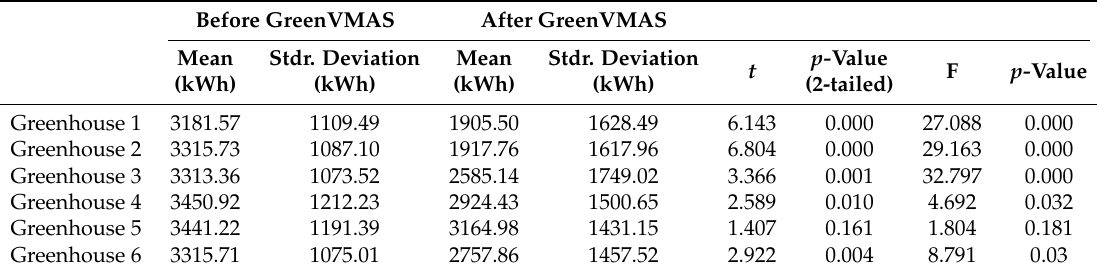
Table 6. Results of the Student’s t -test and Levene’s test performed on a summer tomato cultivation. These tests were performed to assess the difference of means (electrical consumption in kWh) and variances between the data obtained before and after using GreenVMAS. Before GreenVMAS After GreenVMAS